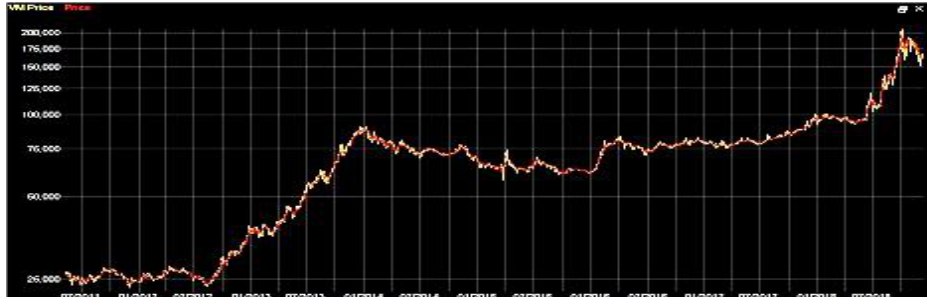
Fig. 4. Time series plot of TEPIX at 90% of the total population; the red curve is the historical “TEPIX” quotes; the yellow curve is the series estimated by ‘Residual